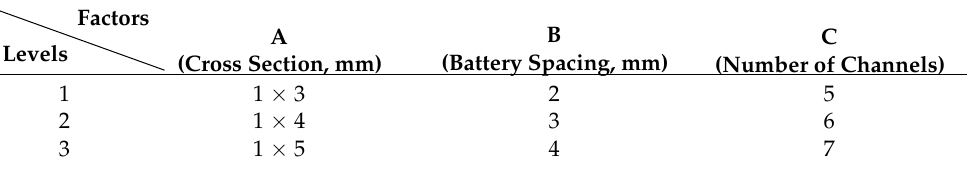
Table 4. Factors and levels in orthogonal experimental